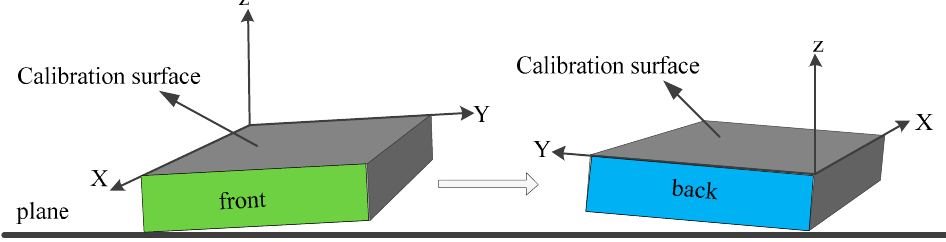
Figure 6. Schematic diagram of two rotations of the same calibration surface.